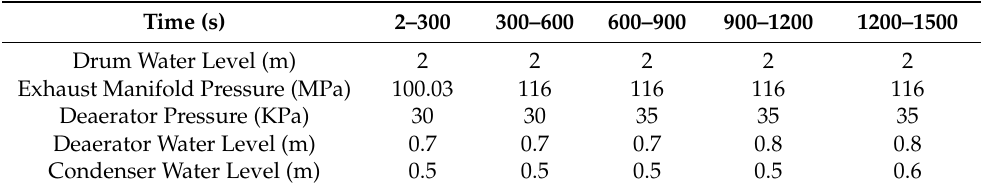
Table 3. Step set points changes in the